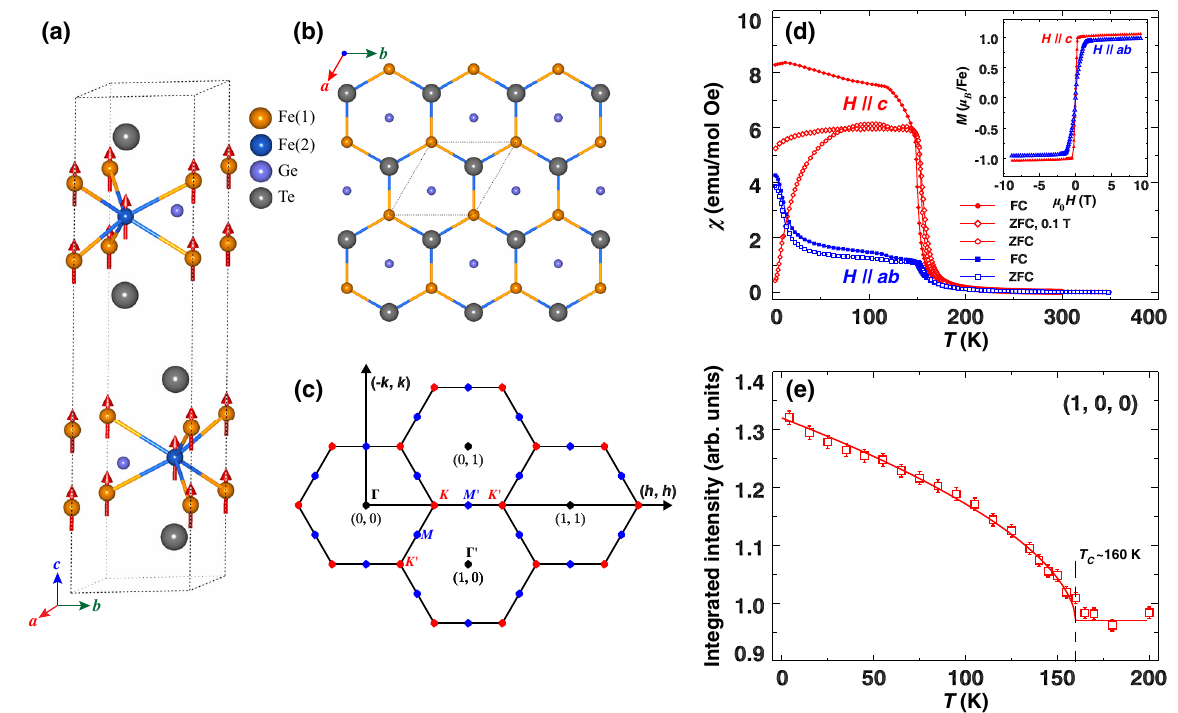
FIG. 1. (a) Schematic crystal and magnetic structures of Fe 3 GeTe 2 . There are two inequivalent sites of Fe atoms, labeled as Fe(1) and Fe(2), respectively. Arrows indicate the magnetic moments on Fe atoms. (b) Top view of the hexagonal structure in the a - b plane. For clarity, only one Fe 3 Ge slab sandwiched by two Te layers is shown. (c) Two-dimensional Brillouin zones with high-symmetry points in the ð h; k Þ plane. (d) Temperature dependence of the magnetic susceptibility on a single crystal of Fe 2 or squares represent the magnetization measurements under zero-field-cooling (ZFC) and field-cooling (FC) conditions, respectively. The inset shows magnetization M – H curves at T ¼ 2 . 5 K, with the magnetic field applied along the c axis and in the a - b plane. The magnetic field applied was 0.01 T, unless marked otherwise. (e) Temperature dependence of the integrated intensities of the magnetic Bragg peak (1,0,0) measured on SIKA, plotted in an arbitrary unit (arb. units). The error bars represent one standard deviation throughout the paper. The solid line is a guide to the eye. The dashed line indicates the Curie temperature T